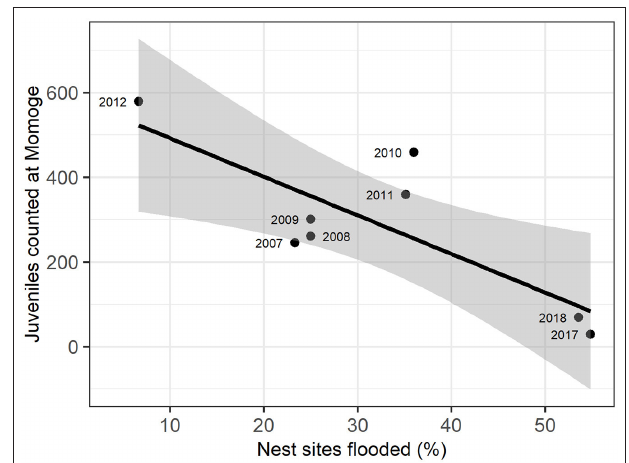
FIGURE 2 | Yearly percent of flooded nest sites over the study period. Solid line represents linear fit of points (adjusted R 2 = 0.34), with gray areas representing 95% confidence intervals. Dashed line represents mean percent of nest sites flooded over the years (30.2% ± 13.9). Nest flooding was significantly increasing over the study period (F-statistic = 10.9, p = 0.008).